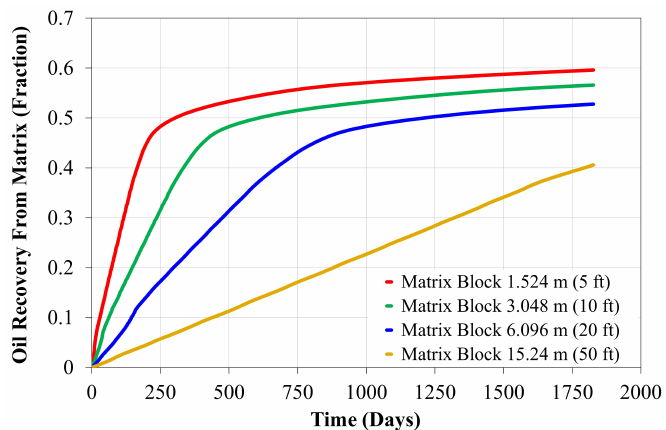
Figure 13. Comparison of the oil recovery from the matrix blocks using various matrix block dimensions of (1.524, 3.048, 6.096, and 15.24 m) by assuming (lx = ly = lz). The speed of recovery increased significantly when the matrix blocks are small, e.g., 40% of oil recovery required 167 days when the matrix block dimensions are (1.524 × 1.524 × 1.524 m 3 ) compared to 1795 days that required for the same recovery when the dimensions are (15.24 × 15.24 × 15.24 m 3 )